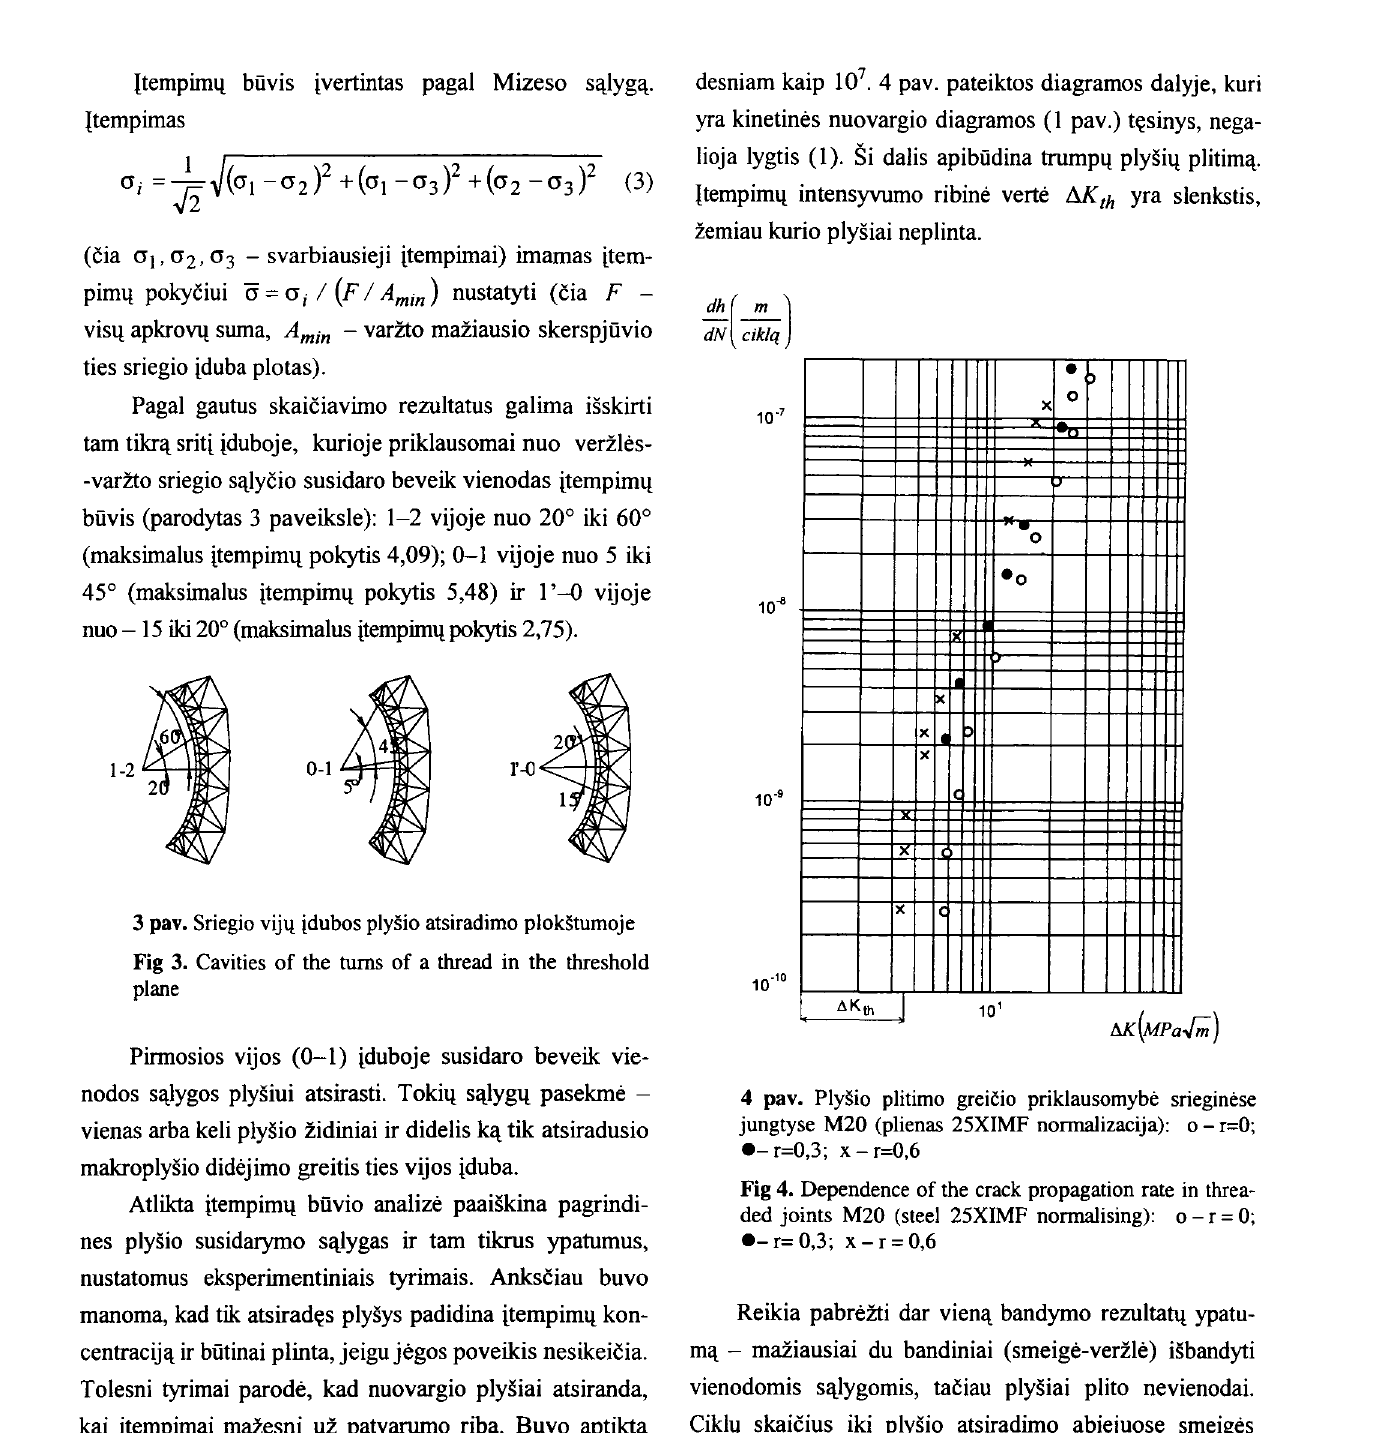
4 pav. Plysio plitimo greicio priklausomybe srieginese jungtyse M20 (plienas 25XIMF nonnalizacija): o - r=O; •- r==0,3; x- r=0,6 Fig 4. Dependence of the crack propagation rate in threa ded joints M20 (steel 25XIMF nonnalising): o - r = 0; •-r=0,3; x-r=0,6 Reikia pabreZti dar vien'l_ bandymo rezultatq ypatu ffi'l- maiiausiai du bandiniai (smeige-verzle) iSbandyti vienodomis s'l_lygomis, taciau plysiai plito nevienodai. Ciklq skaicius iki plysio atsiradimo abiejuose smeiges galuose neiyrniai skyresi. Tuo tarpu ciklq skaiCius iki visisko suirimo (kai kuriuose bandiniuose) zymiai skyresi. Taip pat plysys viename is smeiges galq gali sustoti. Au toriq nuomone, smeigeje plintantys plysiai pakeicia ir'litt srautus sistemoje smeige-verzle, del to sumazeja